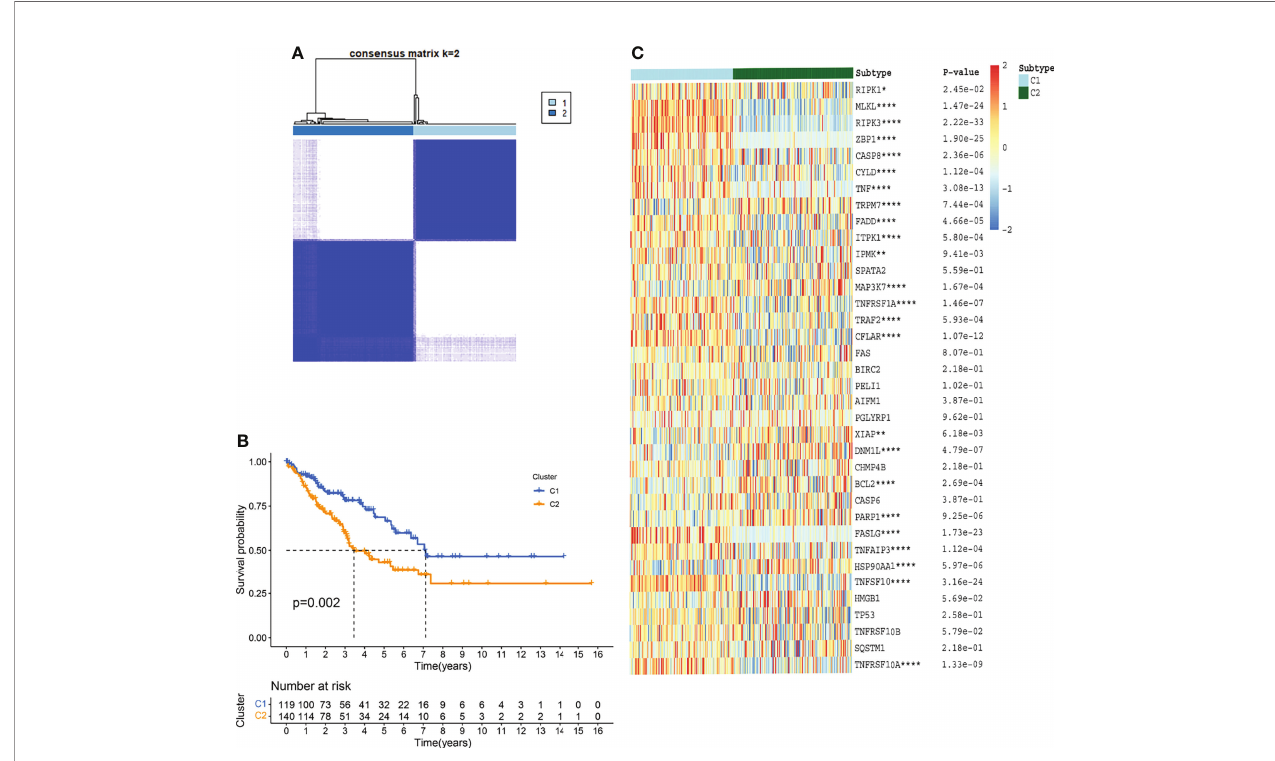
FIGURE 4 | TCGA-SARC clusters based on NRGs through consensus clustering analysis. (A) TCGA-SARC cohort was divided into two distinct clusters (k=2, repetition=5000) (B) Overall survival (OS) curve of two clusters (C) Heatmap of NRGs among two clusters. ns, p ≥ 0.05; *, 0.01 ≤ p < 0.05; **, 0.001 ≤ p < 0.01; ***, 0.0001 ≤ p < 0.001; ****p <